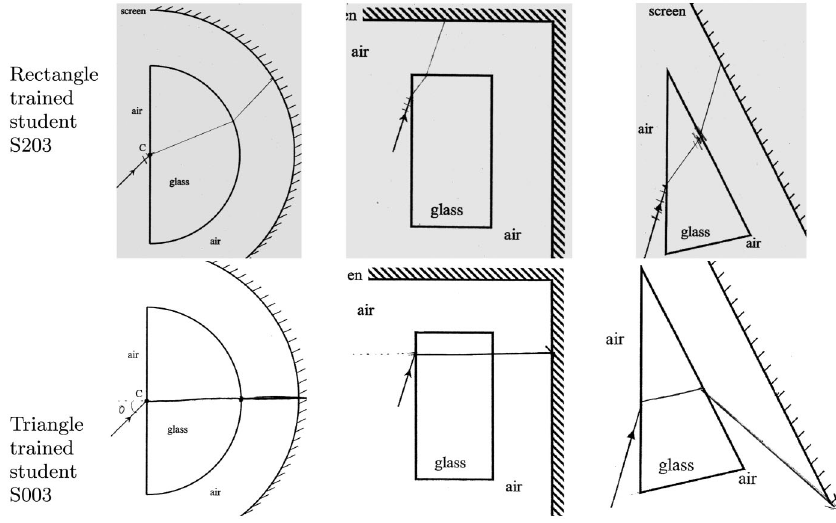
FIG. 3. Two subjects’ responses to test questions 1,2, and